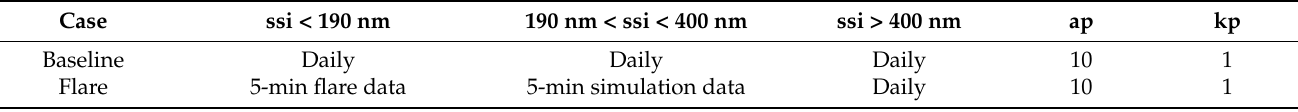
Table 1. Summary of simulations performed on 18 October